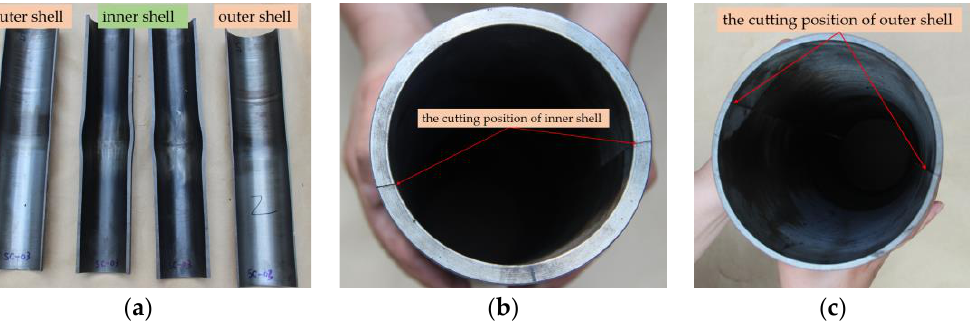
Figure 7. Photographs of double-layer steel cylinders after cutting. ( a ) Double-layer shells after cutting. ( b ) Inner shell after cutting. ( c ) Outer shell after cutting.